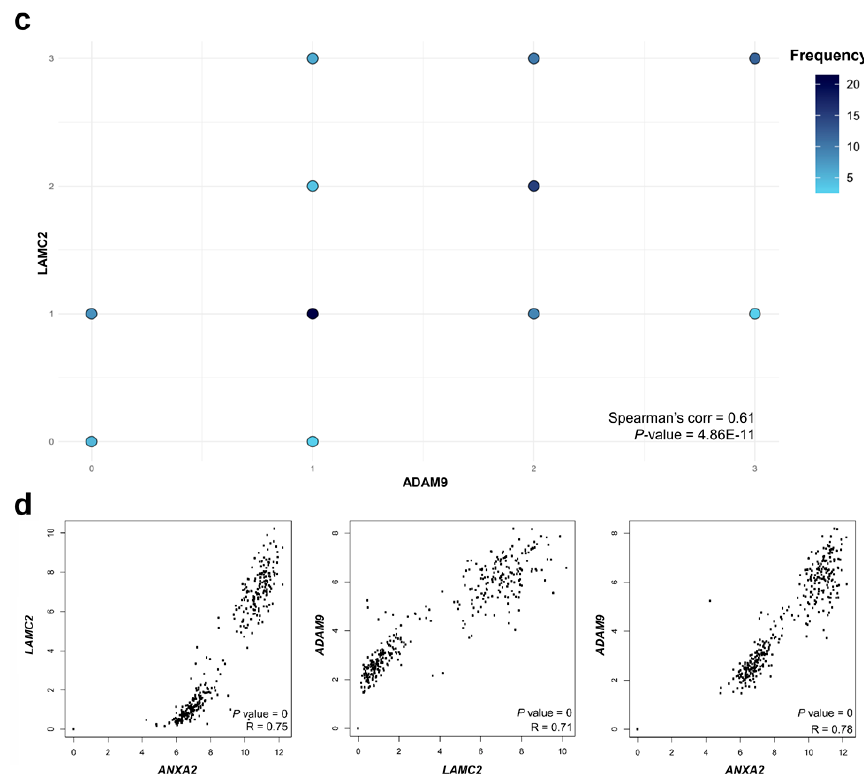
Figure 4. Immunohistochemical analysis for determination of LAMC2 , ADAM9 , and ANXA2 ( Annexin A2 ) gene expression. ( a ) Scoring system for the three proteins in pancreatic tissues. ( b ) IHC scores of LAMC2 , ADAM9 , and ANXA2 in pancreatic tumors and normal controls ( n = 86). ***: p < 0.001; ****: p < 0.0001. ( c ) Pairwise correlation of LAMC2 , ADAM9 , and ANXA2 expression. ( d ) Pairwise correlation of LAMC2 , ADAM9 , and ANXA9 at gene expression level (log 2 of transcripts per million) in TGCA PC, TCGA normal pancreas, and Genotype-Tissue Expression Project (GTEx) derived normal pancreas.